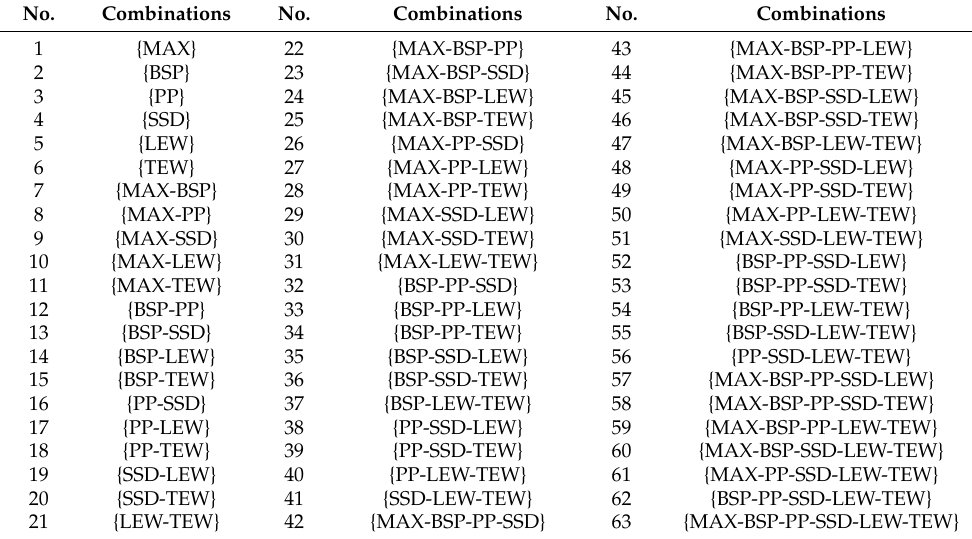
Table A1. The 63 multi-feature